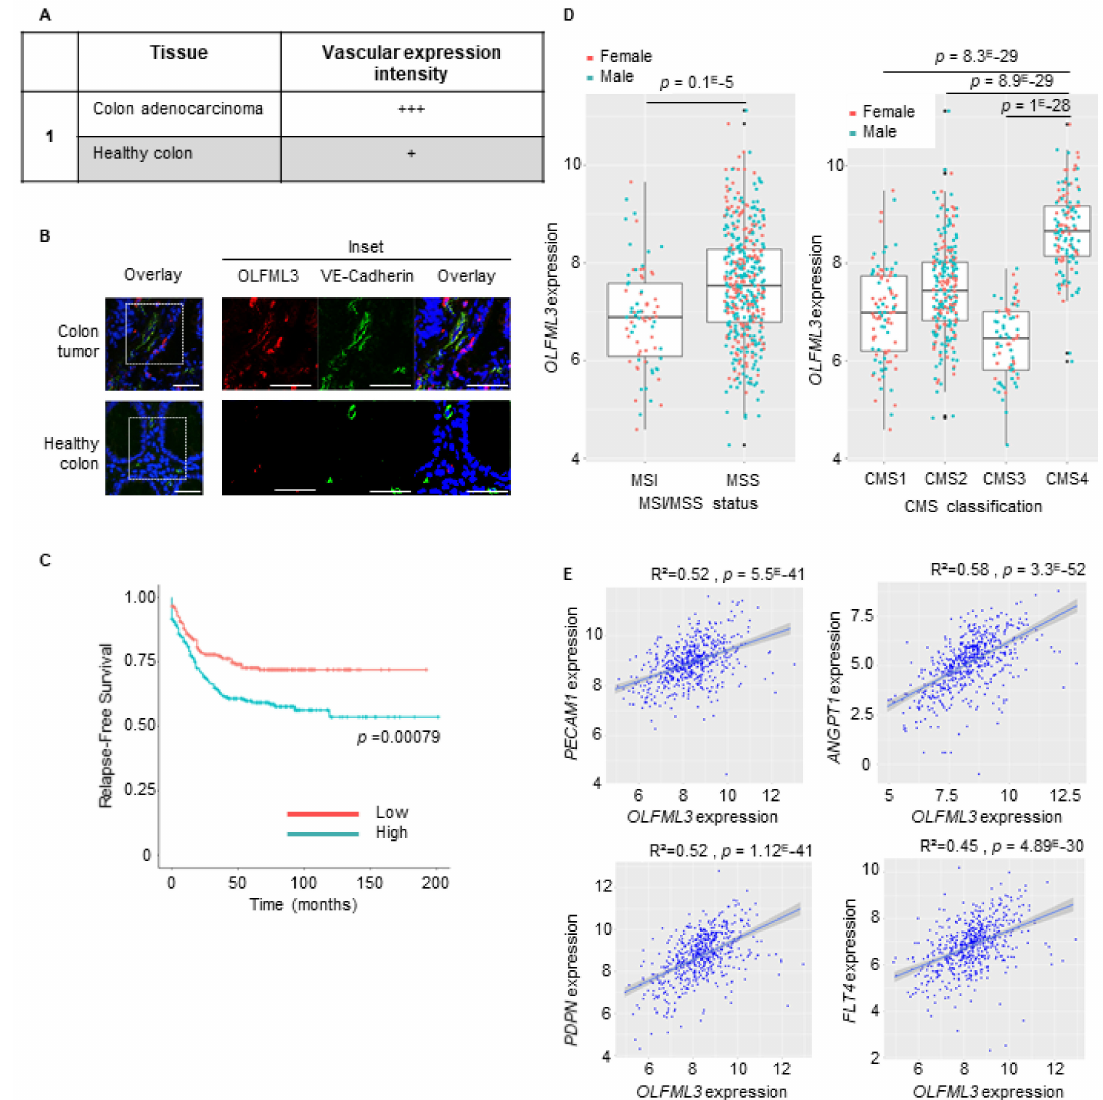
Figure 1. Expression of OLFML3 in colorectal cancer (CRC) correlates with shorter relapse-free survival, with microsatellite stable status (MMS) and consensus molecular subtypes 4 (CMS4), and with the expression of angiogenic factors. ( A ) Vascular expression intensity of OLFML3 was ranked as follows: none ( − ), low (+), moderate (++), or strong (+++). ( B ) Representative confocal images of VE-cadherin+ (green)- and OLFML3+ (red)-stained tumor vasculature in sections of CRC and healthy colon tissue. Note the difference in abundance of vascular VE-cadherin+ and perivascular cells in OLFML3-expressing tumors relative to that in healthy colon tissue. DAPI (blue), nuclear counterstain (overlays). Scale bars = 50 µ m. The right panel is a zoom image of the frame of the left panel. ( C ) Kaplan–Meier survival analysis of the index of OLFML3 mRNA expression (low (red) vs. high (blue)) relative to the median value in CRC patient tumor samples. (( D ), left) Expression of OLFML3 mRNA in CRC patient tumor samples according to microsatellite instable/microsatellite stable status (MSI/MSS). (( D ), right) Expression of OLFML3 mRNA in four consensus molecular subtypes (CMS 1–4) from CRC patients. ( E ) Scatter plots with linear regression lines (blue) showing the correlation between levels of OLFML3 mRNA and that of angiogenic markers (PECAM1, ANGPT1, PDPN, FLT4) in CRC samples and normal colon tissue. Levels of OLFML3 mRNA in different subgroups of patients were compared using a t -test with equal variance. The correlation between the expression of OLFML3 and that of genes of interest was calculated using Pearson’s and Spearman’s rank correlation